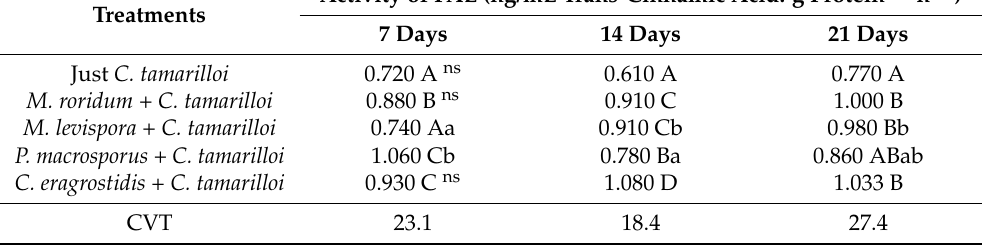
Table 4. Activity of the enzyme PAL in rubber tree seedlings after preventive treatments with saprobic fungi.